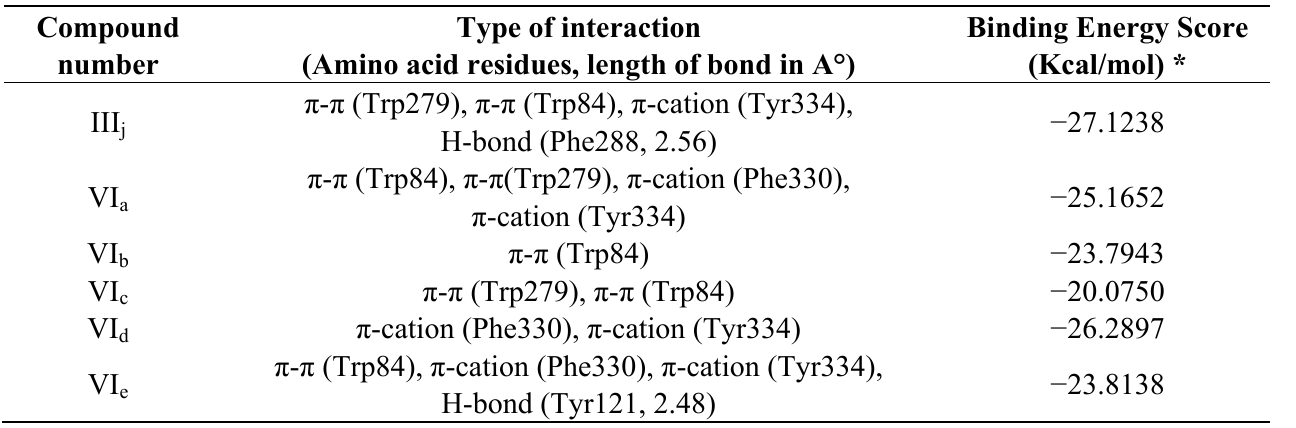
Figure 4. Interactions of donepezil with the amino acids of the AChE active site.